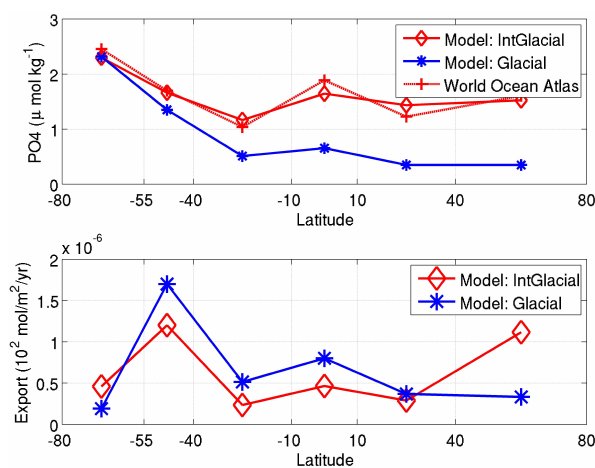
Table 3. The mean and standard deviation of the change in p CO 2 due to a change in the input parameters for the 300 glacial and interglacial states, and for 300 randomly chosen states. For the circulation parameter the difference in p CO 2 due to a change in the circulation from 5 to 20Sv is shown and for the nutrient utilization the difference in p CO 2 due to a change in α from 2 to 8e–10s − 1 . Transport fluxes Glacial Interglacial Random (ppm/15Sv) (ppm/15Sv) (ppm/15Sv) AABW ( T A ) 73 ± 6 26 ± 5 44 ± 20 Ekman ( T T ) 5 ± 12 0 ± 5 − 7 ± 16 Eddies ( T ME ) − 10 ± 8 11 ± 4 Eq-upwell ( T E ) 30 ± 8 16 ± 6 North-upwell ( T N ) 67 ± 7 Model Boxes Glacial Interglacial Random (ppm/6 × 10 10 s − 1 ) (ppm/6 × 10 10 s − 1 ) (ppm/6 × 10 10 s − 1 ) Antarctic (A) − 5 ± 2 − 20 ± 3 − 20 ± 10 Sub-Antarctic (S) − 6 ± 3 − 16 ± 3 − 7 ± 5 Low lats (LS, LN)) − 27 ± 7 Equatorial (E) − 17 ± 4